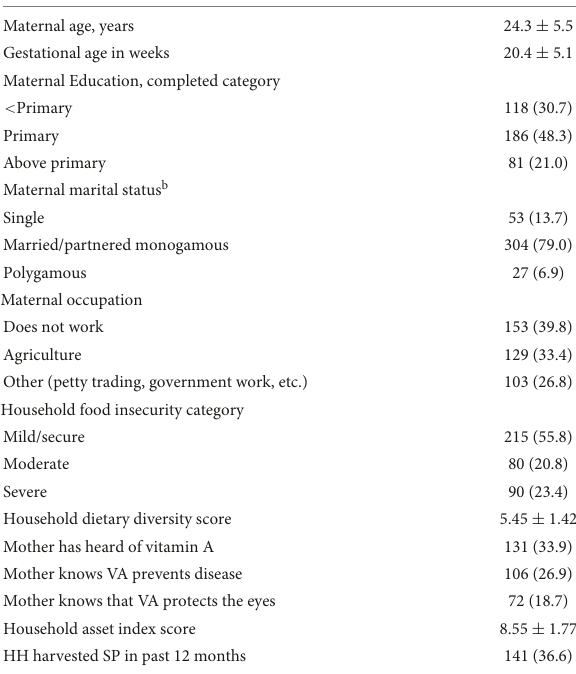
TABLE 1 Sociodemographic and birth characteristics of 385 women participating in the Mama SASHA cohort study in western Kenya. a Characteristic